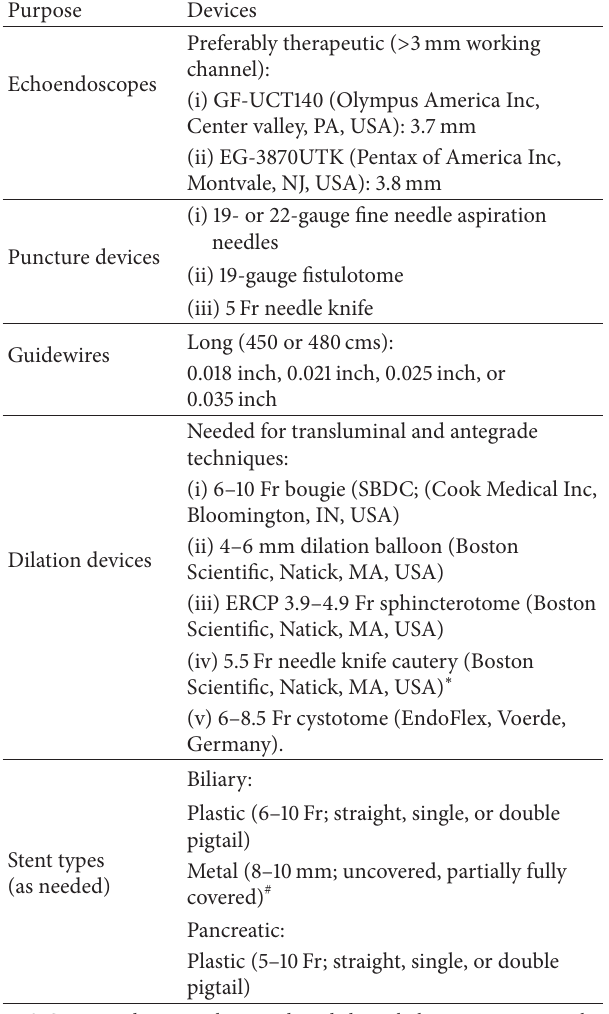
Table 1: Instruments and accessories needed for